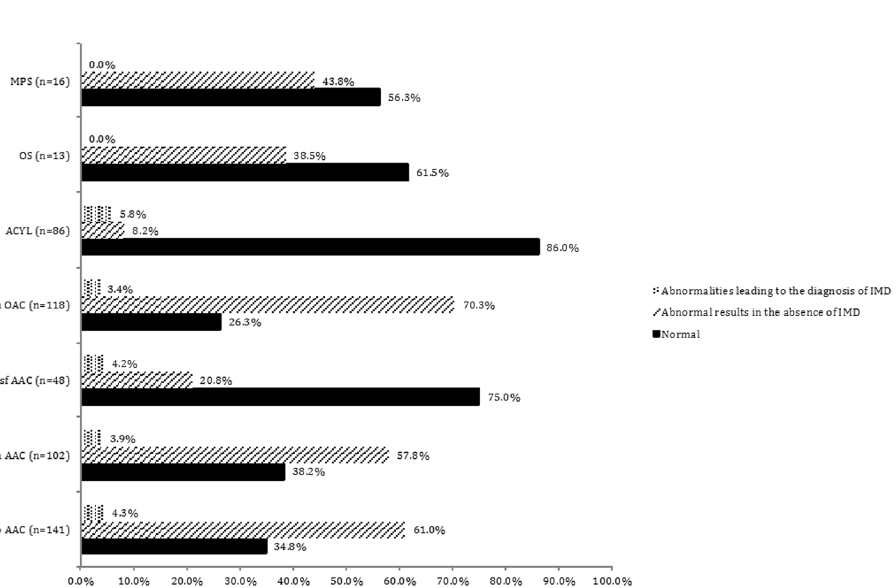
Figure 2. Results of metabolic testings in the whole population (N = 196). pAA: plasma aminoacid chromatography; uAA: urine aminoacid chromatography; CSFAA: cerebrospinal fluid aminoacid chromatography; uOA: urine organic acid chromatography; ACYL: acylcarnitine profile; OS: urine oligosaccharides; MPS: urine mucopoysaccharides.